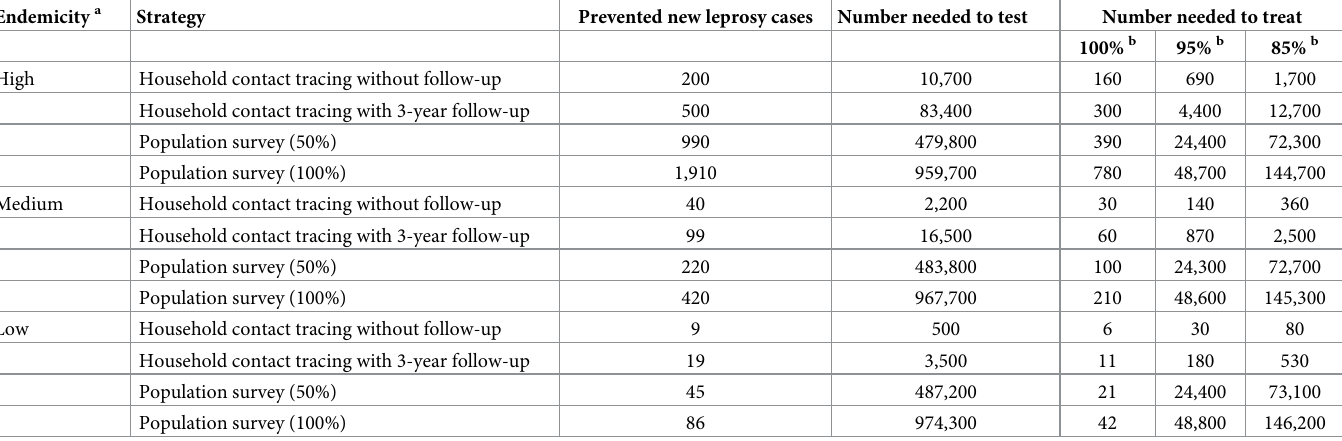
Table 1. Number of prevented new leprosy cases and number needed to test and treat in a population of 1 million after 10 years using a test with 70% sensitivity. Endemicity a